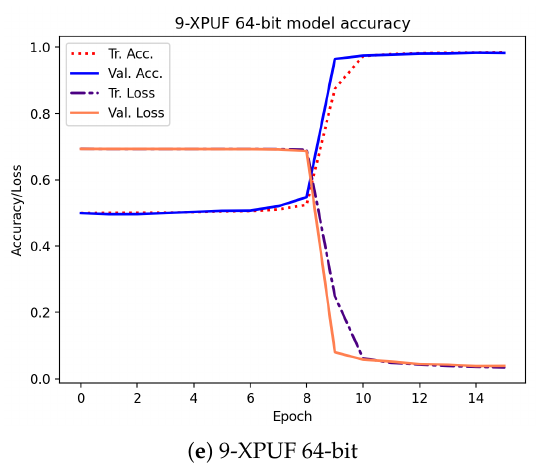
Figure 5. Training and validation curves over epochs for our attacking model that was captured while attacking the XPUFs, with a different number of components ranging from 5 to 9.